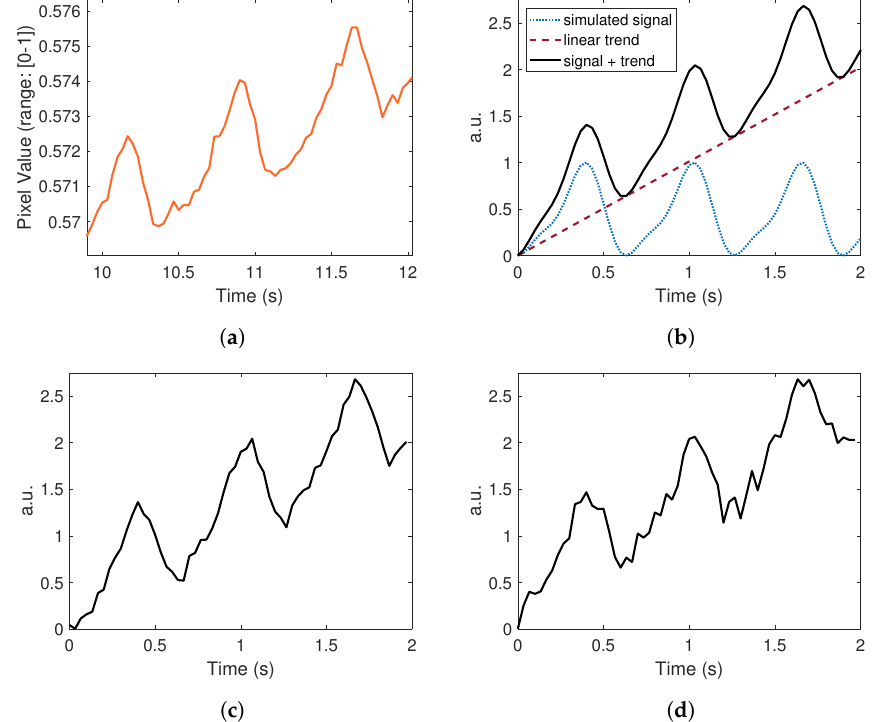
Figure 5. Comparison between signals produced by the synthetic generator and a real PPG signal. ( a ) Excerpt of subject #1 raw PPG signal taken from the UBFC-RPPG dataset. Pixels from the forehead area (green channel) have been spatially averaged to compute the signal. ( b ) Dotted blue line: simulated PPG signal (output of Figure 2b). Dashed crimson line: linear trend. Solid black line: signal combined with the trend. ( c , d ) Signals outputted by the generator with two different noise factors. They were computed using a spatial averaging operation over all the pixels of the synthesized frames. The produced signals are pretty similar to the real PPG signal presented in figure